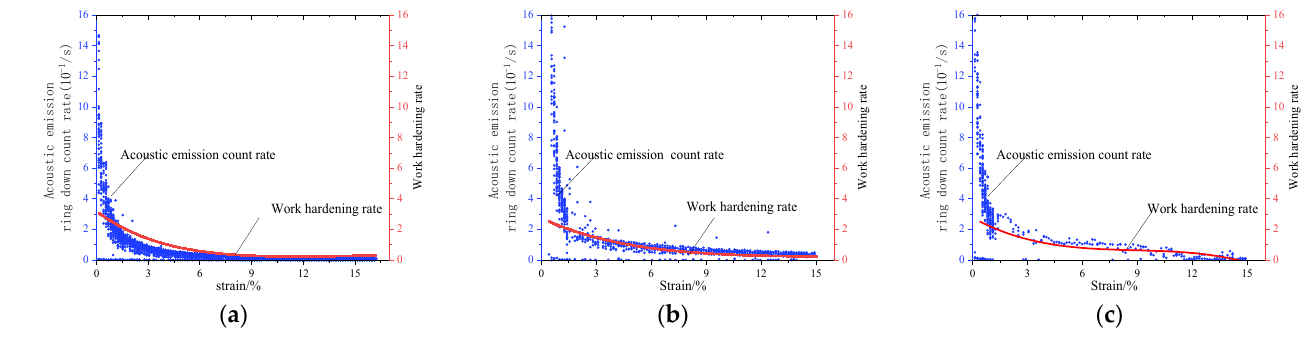
Figure 11. Acoustic emission count rate versus work hardening rate at various compression rates.